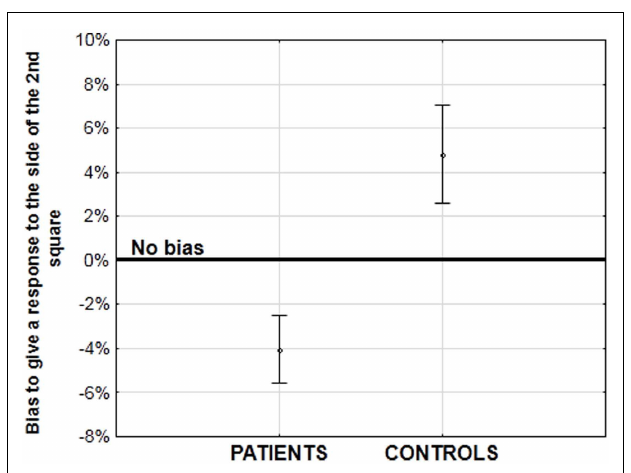
FIGURE 3 |Amplitude of the bias (in%) to the side of the first or second stimulus at short asynchronies, when one stimulus is displayed on the right side of the screen and the other one on the left . A negative bias corresponds to a bias to the side of the first stimulus (in patients), whereas a positive bias corresponds to a bias to the side of the second stimulus (in healthy participants). See Lalanne et al. (2012b), for more detailed